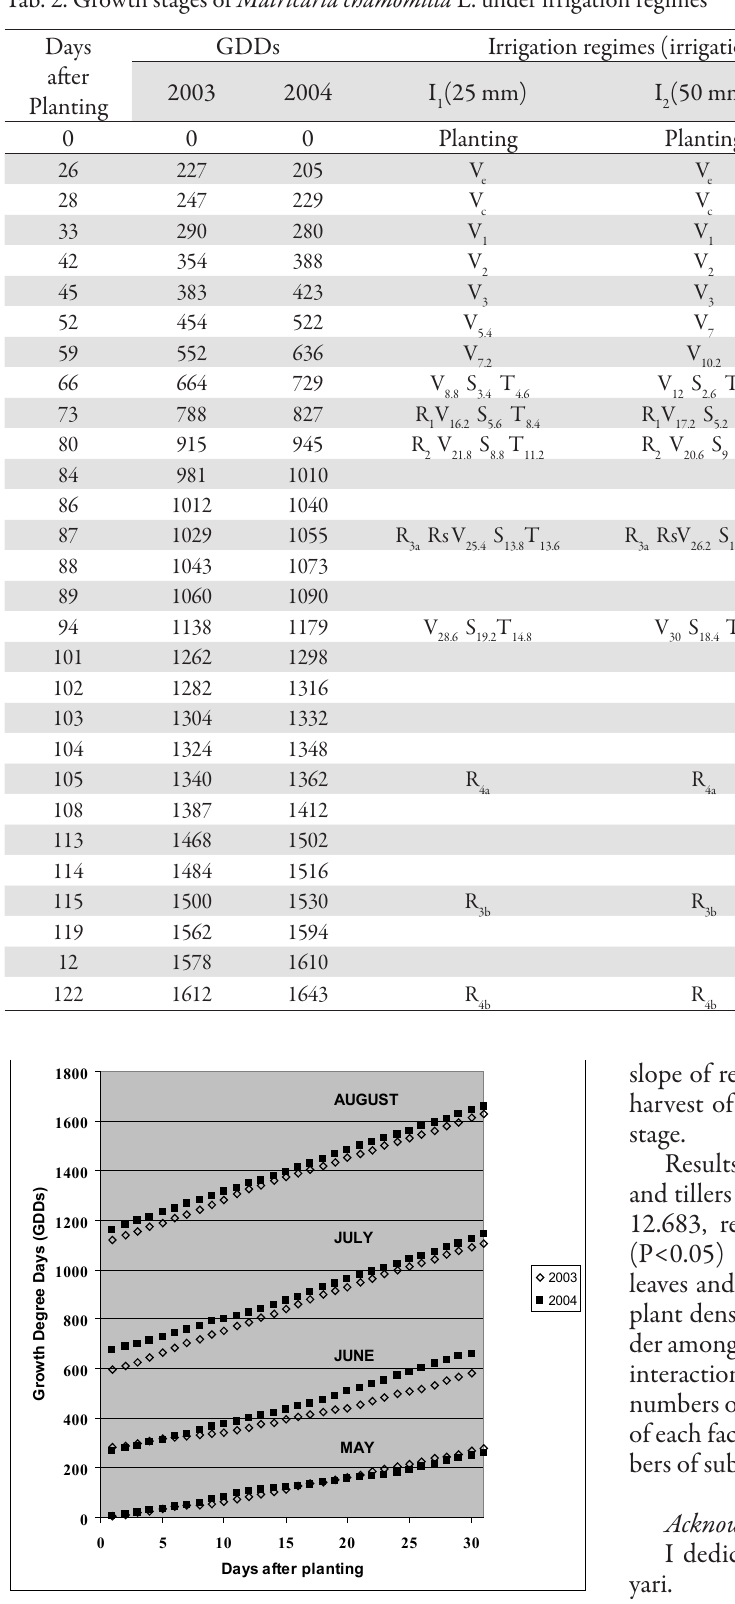
Tab. 2. Growth stages of Matricaria chamomilla L. under irrigation regimes Days after Planting